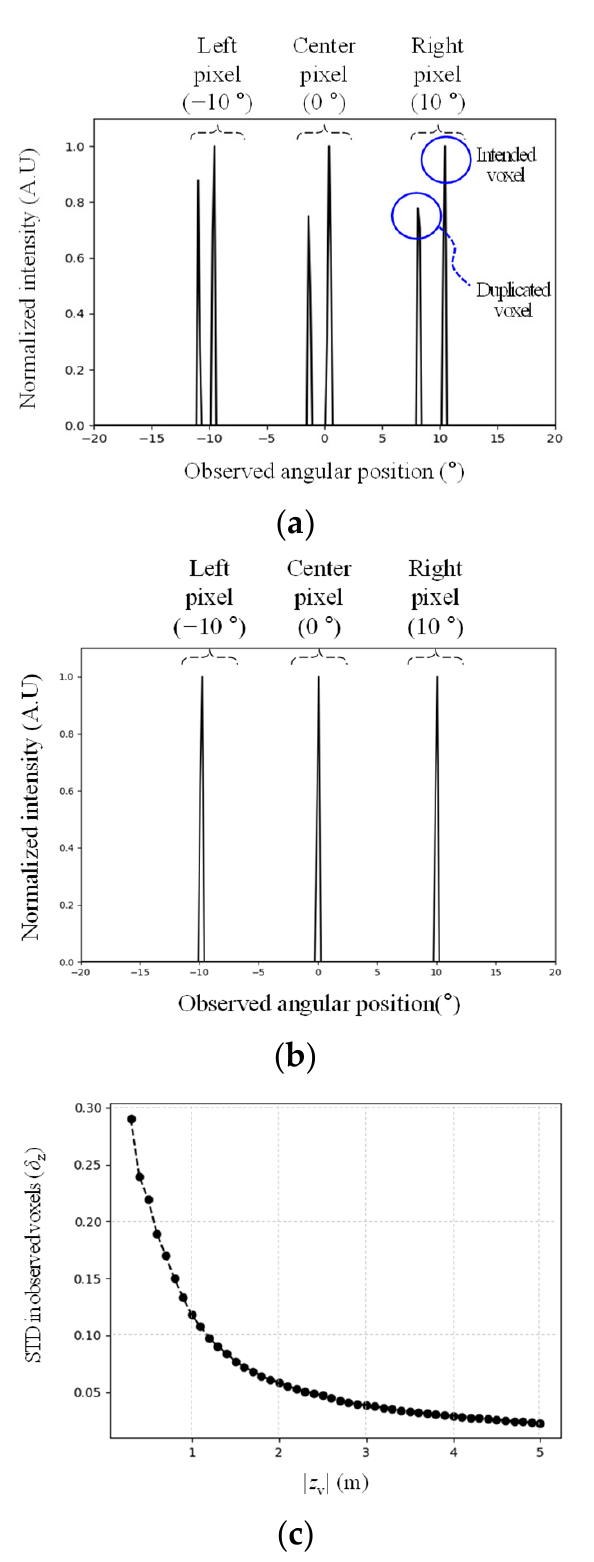
Figure 3. Simulation results for the observation case of voxels through the holographic waveguide: ( a ) z v = −400 mm case, ( b ) z v = −4000 mm case, and ( c ) the comprehensive analysis for the voxel duplication problem according to the represented depths using the evaluation metrics ( δ z